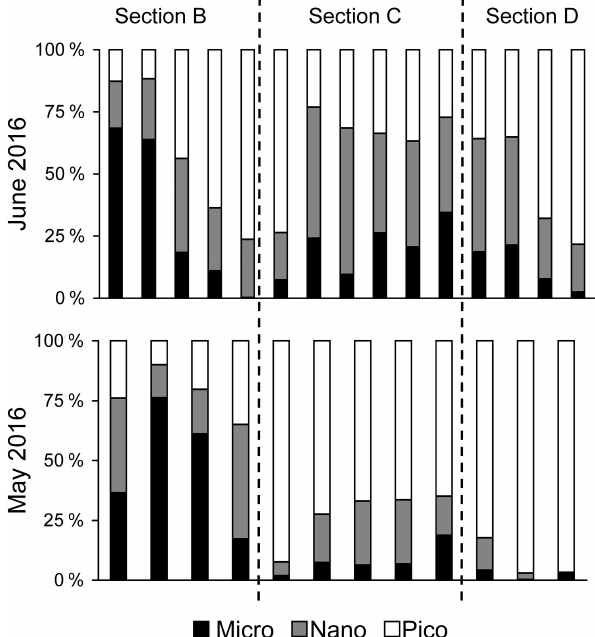
Figure 5. Comparisons of size-fractionation chlorophyll a for sec- tions B, C and D between May and June